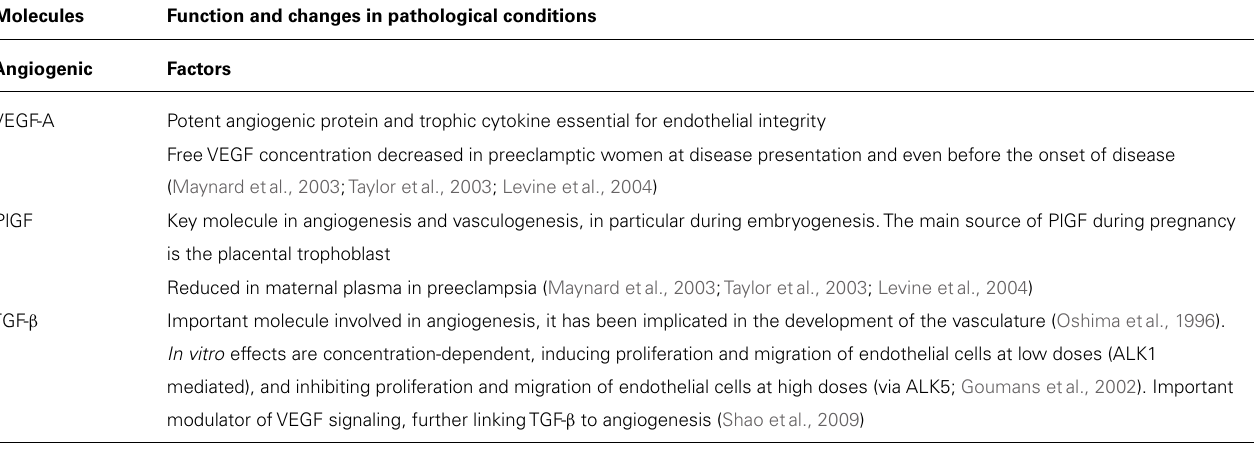
Table 1 |A brief description of function of angiogenic and antiangiogenic growth factors and their receptors in pregnancy. Molecules Function and changes in pathological conditions